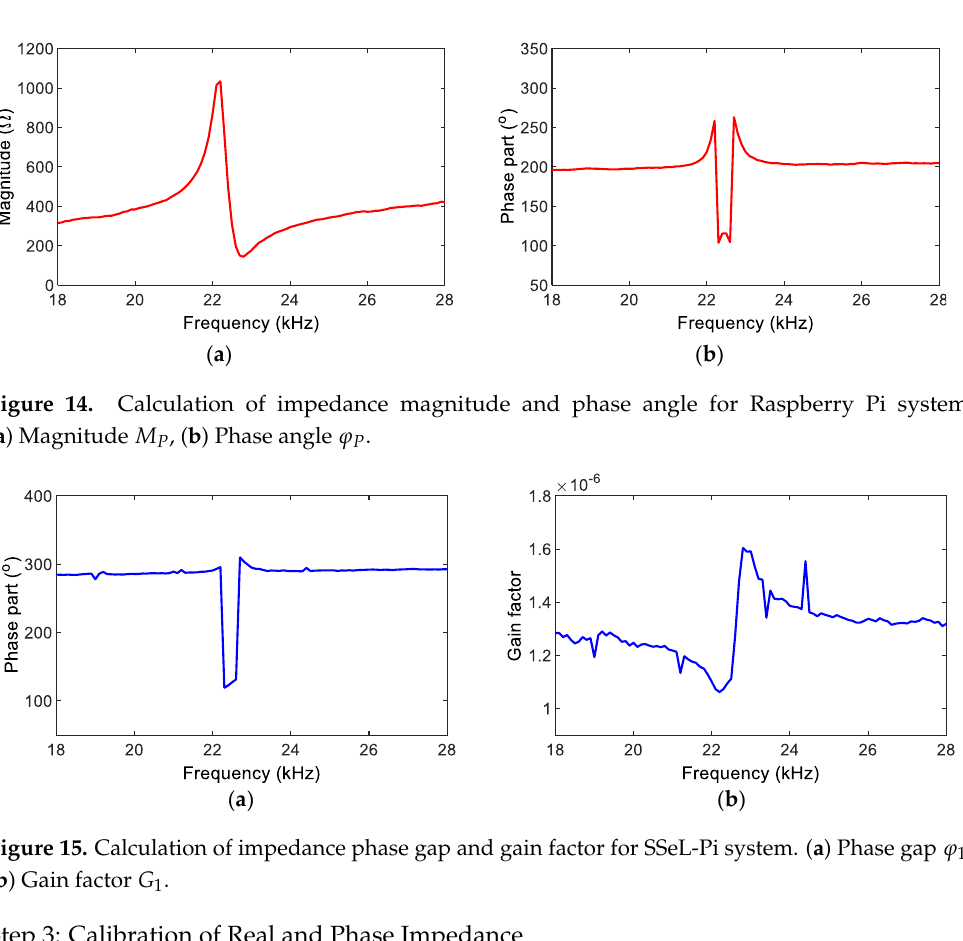
Figure 16. Regression models for impedance phase angle and gain factor. ( a ) Phase fit j factor fit